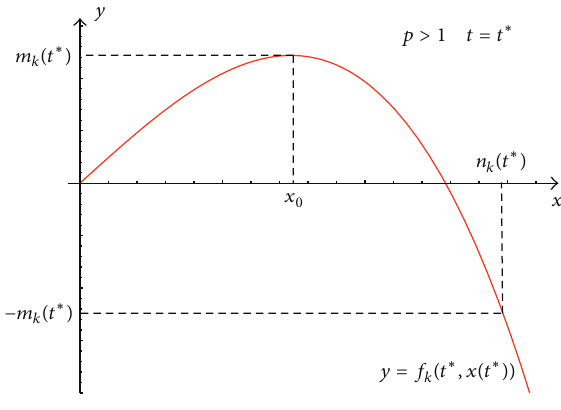
Figure 1: Existence of a number 𝑛 𝑘